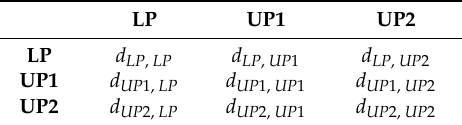
Table 1. Palm relative